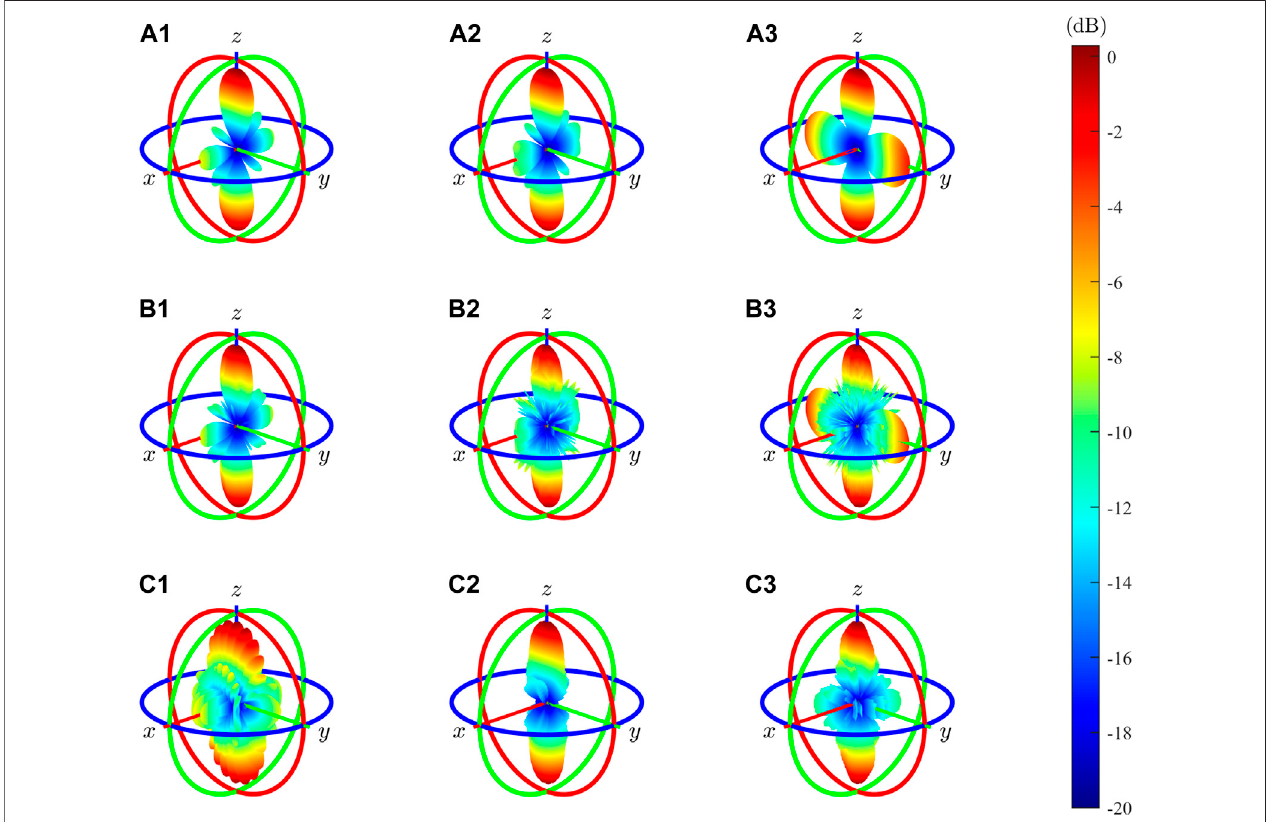
FIGURE 9 | Planar arrrays ’ beampatterns using the beamformers: (A) proposed Kronecker, (B) proposed tradeoff with α = 0.5, and (C) Son, for several frequencies: (1) 2 kHz, (2) 5 kHz, and (3) 8 kHz.